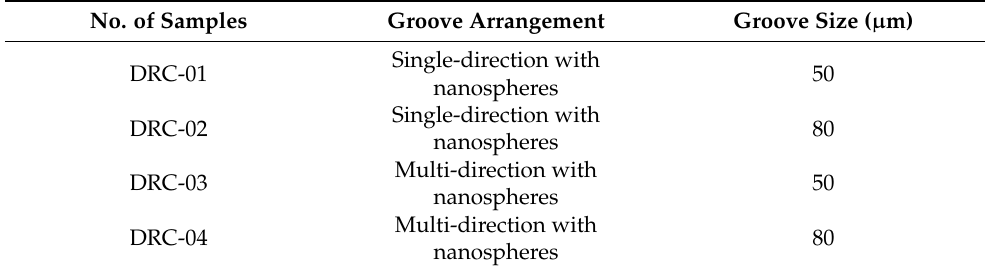
Table 1. The microgroove polyurethane coating structure of four samples.